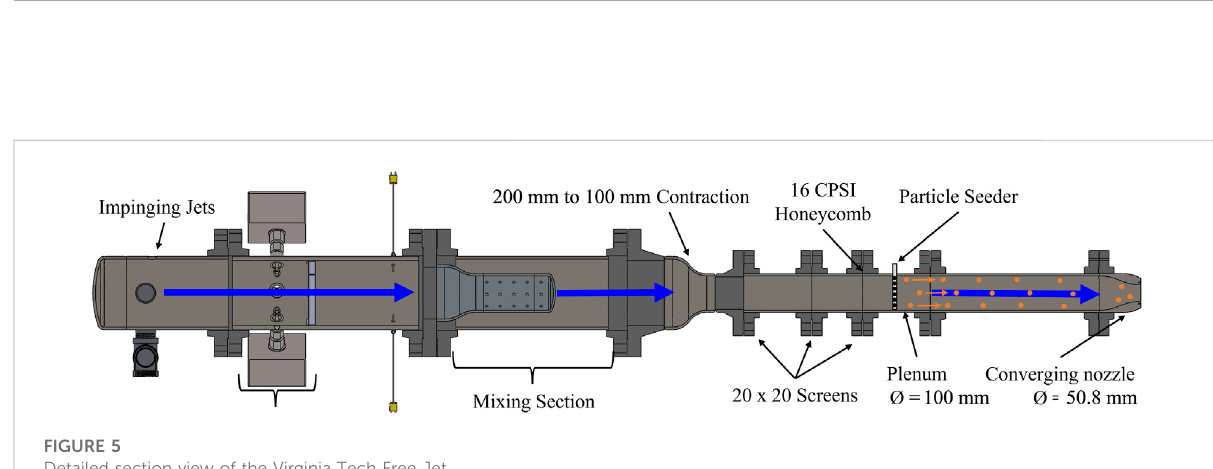
FIGURE 5 Detailed section view of the Virginia Tech Free